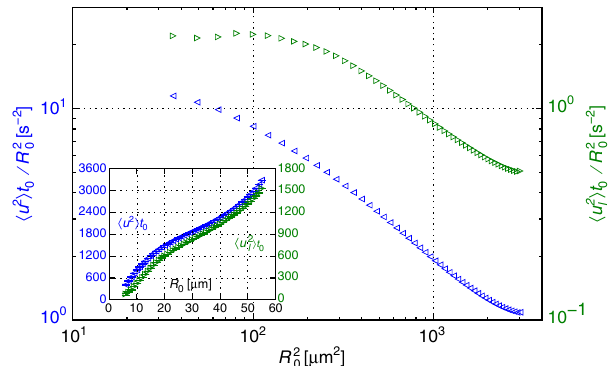
Fig. 3 Initial relative velocity dependence on the separation distance. The (cid:1) (cid:3) ; ( blue left - triangles ) and second moments of the relative velocity u 2 (cid:1) (cid:3) R 0 ; t 0 ; ( green right-triangle ), where u = u ⋅ R / R , are the separation velocity u 2 l l R 0 ; t 0 plotted in the inset ( right axis values are half the left ones) as function of the initial separation distance R 0 ; both ensemble averages are taken at the initial time t 0 , when the pairs separation distance is closest to R 0 . Rescaling these data by the squared initial separation R 2 reveals the deviation from 0 the commonly applied assumption of linear velocity fi eld, as presented on a logarithmic scale in the main plot ( right axis values are one order of magnitude smaller than the left ones). Had 〈 u 2 〉 R ∝ R 2 held, the rescaled curves would have remained constant; this is clearly not the case. Indeed, (cid:1) (cid:3) = R 2 ; data level off as R the u 2 0 approaches the smaller distances, 0 l R 0 ; t 0 providing supporting evidence for the linearity of u l with R at scales smaller than 12 μ m. However, this does not hold beyond a tenth of the channel depth. A linear fl ow regime is not supported by the rescaled relative 2 velocity data u 2 h i , which values keep increasing even for the smallest (cid:1) (cid:3) (cid:1) (cid:3) R 0 ; t 0 R 0 R 0 values explored here. Further note that u 2 and u 2 ( inset ) are l R 0 ; t 0 R 0 ; t 0 empirical estimators for the second order structure functions of the velocity and the longitudinal velocity, correspondingly; the former is the coef fi cient of the quadratic term in Eq. (2). The error bars in the inset (smaller than the marker) indicate the margin of error based on a 95% con fi dence interval Fig. 4 Relative pair dispersion forward and backwards-in-time evolutions. for various initial separations ( inset ) a Forward-in-time h R ð δ t Þ (cid:3) R 0 k k 2 i R 0 between 6 and 50 μ m, collapse initially on a single curve which follows a power-law δ t 2 , once rescaled by the average squared relative velocity at the . A signi fi cant deviation from δ t 2 is noticed after 2 – 3 s, initial time, h u 2 i R 0 ; t 0 indicating the time beyond which higher order terms should be considered. k 2 i for the R 0 same initial separations ( inset ), showing the same initial scaling collapse